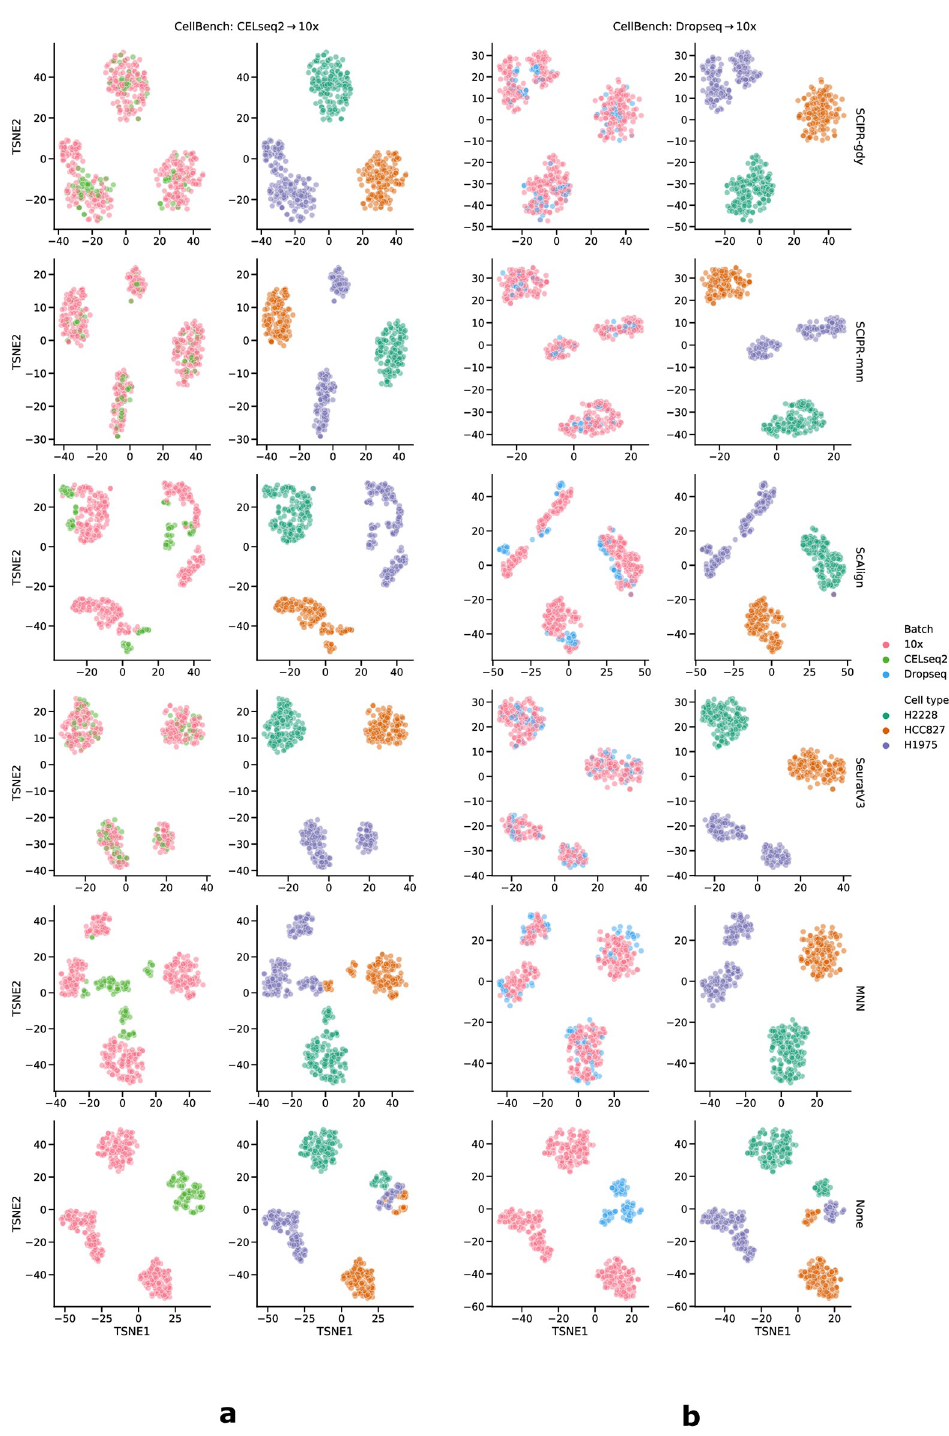
Fig 3. Embedding (t-SNE) visualization from alignment tasks on the CellBench dataset using various alignment methods. Each row is a different alignment method (the bottom row,“None”, is with no alignment). The columns are in two groups based on alignment task: the left two columns (a) pertain to aligning the CELseq2 batch onto the 10x batch, the right two columns (b) are for aligning the Dropseq batch onto the 10x batch. The first and third columns are colored by batch, and the second and fourth columns are colored by cell